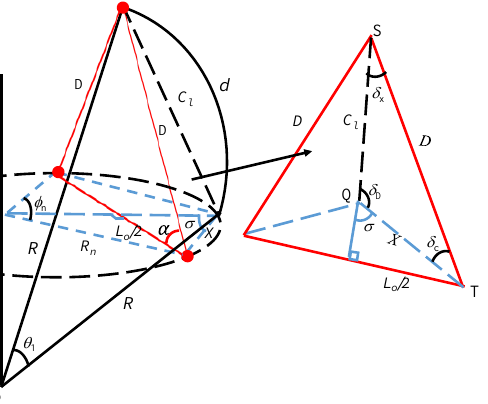
Figure 4. Schematic representation of the geometrical relationship between the geodesic triangle and the platform.